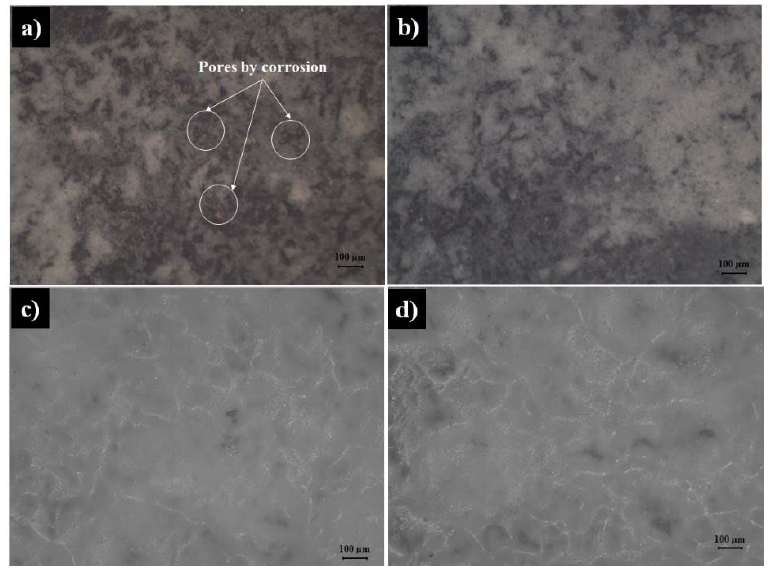
Table 2. Polarization parameters obtained from Tafel curves.